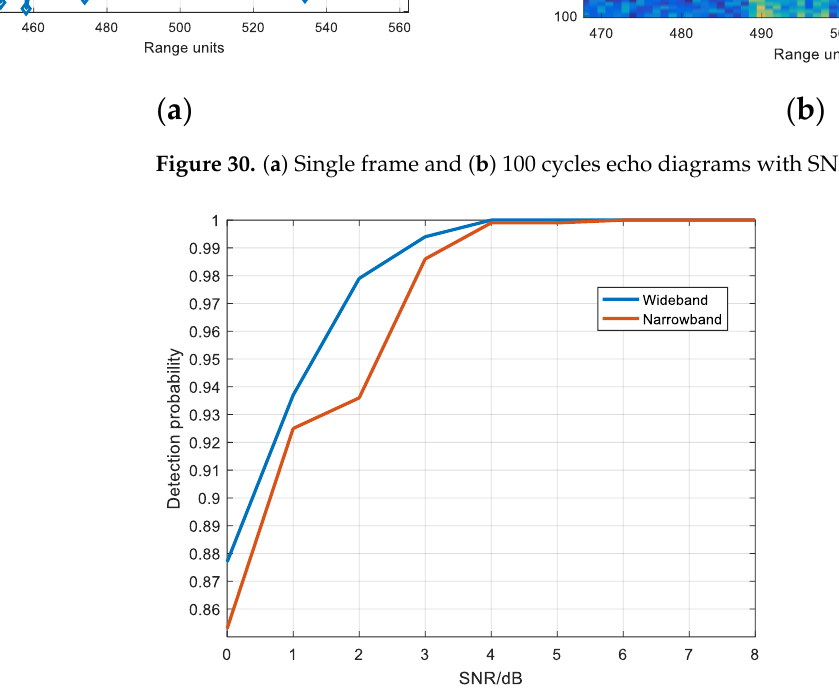
Figure 31. Detection probability diagram of wideband and narrowband under different SNR.